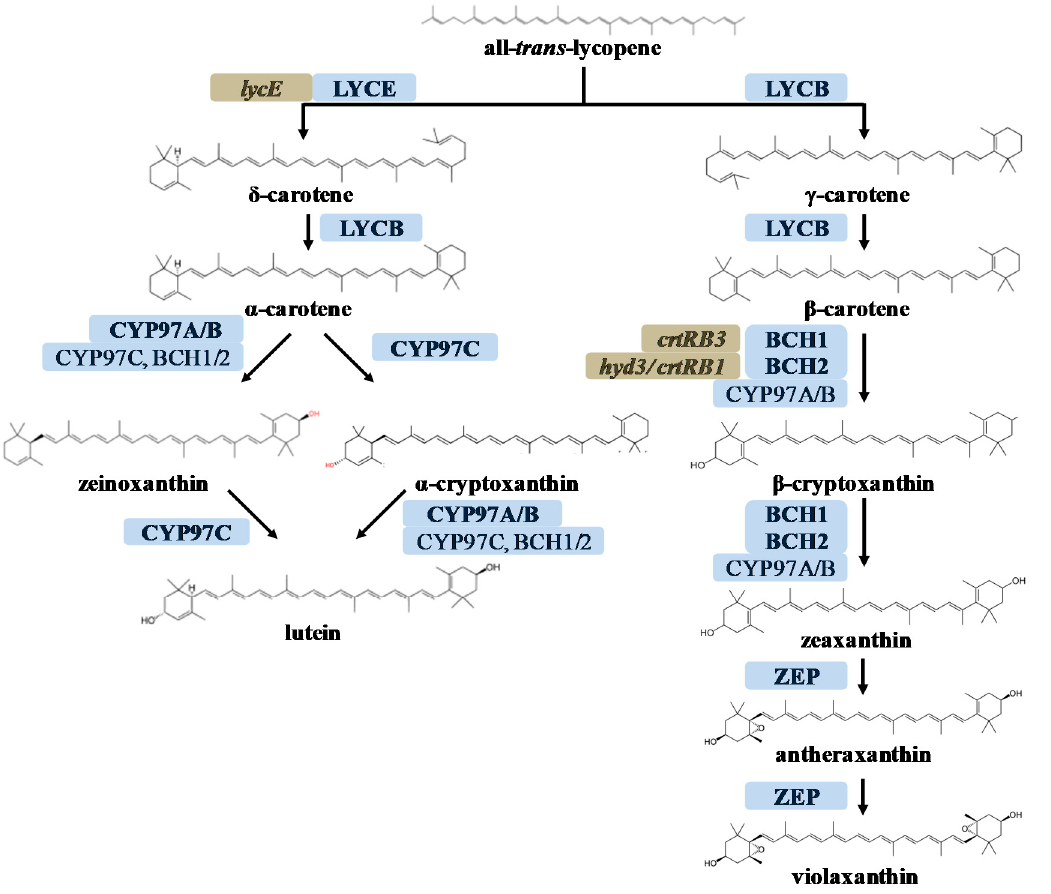
Figure 1. Xanthophyll biosynthesis pathway in maize endosperm. Enzymes responsible for the major activity at each step are shown in bold (blue). Identified maize locus names corresponding to each enzyme are shown in brown. Abbreviations: LYCB, lycopene β -cyclase; LYCE, lycopene ε -cyclase; CYP97C, heme-containing cytochrome P450 carotenoid ε -ring hydroxylase; CYP97A/B, heme-containing cytochrome P450 carotenoid β -ring hydroxylase; BCH1/2, Non-heme di-iron β -carotenoid hydroxylases; ZEP, zeaxanthin epoxidase.